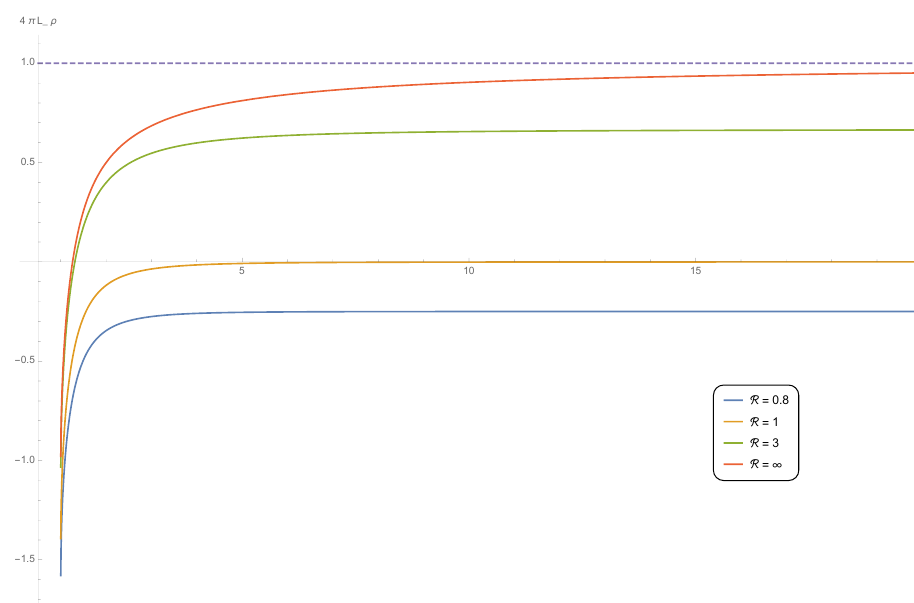
Figure 7 . Above is a plot of the energy density of the screen as a function of its placement for the case when d = 3 and r H /L − = 1 . Each solid line is a plot of the energy density of the screen in units of the interior AdS radius, L − for different choices of the ratio R = L + /L − . We can see that all the lines start at r 0 /L − = 1 which is where the horizon of the black hole is. At r 0 /L − = 1 the energy density given by eq. (H.7) and will be negative. All the lines then increase monotonically and will saturate to a value given by eq. (H.8) at infinity. For cases when R < 1 the energy density at the conformal boundary will saturate to a negative value. When R = 1 the energy density is always negative and saturates to zero at the conformal boundary. When R > 1 the energy density is positive if r 0 > r c where r c is given by eq. (H.11). The red curve corresponding to the limit when R = ∞ represents the case when we patch a flat exterior metric at the screen interface and the dotted line is the value the energy density will saturate to at infinity. The main features of the energy density as illustrated in this plot remain intact if we consider higher dimensions and different values of r H /L −